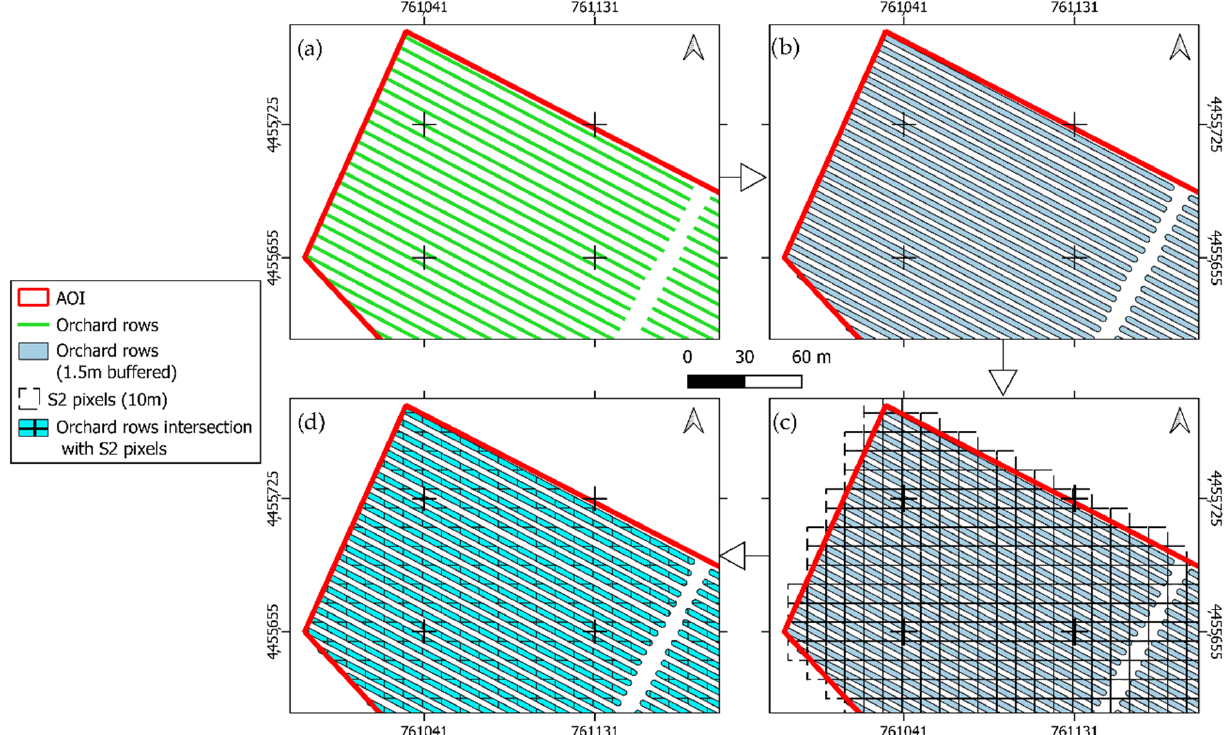
Figure 4. Sequence of GIS operations needed to map the percentage of pomegranate canopy ( β ) within S2 pixels: ( a ) orchard row editing (from AGEA orthoimage); ( b ) buffering (1.5 m width); ( c ) graticule generation; ( d ) intersection between graticule and buffers (the reference system is WGS 84/UTM 33N, EPSG: 32633). Table 3. Spectral indices used for this work. ρ b3 , ρ b4 , ρ b5 , ρ b8 , ρ b11 and ρ b12 are the bottom of atmosphere (BOA) reflectance values for S2 bands 3, 4, 5, 8, 11 and 12,